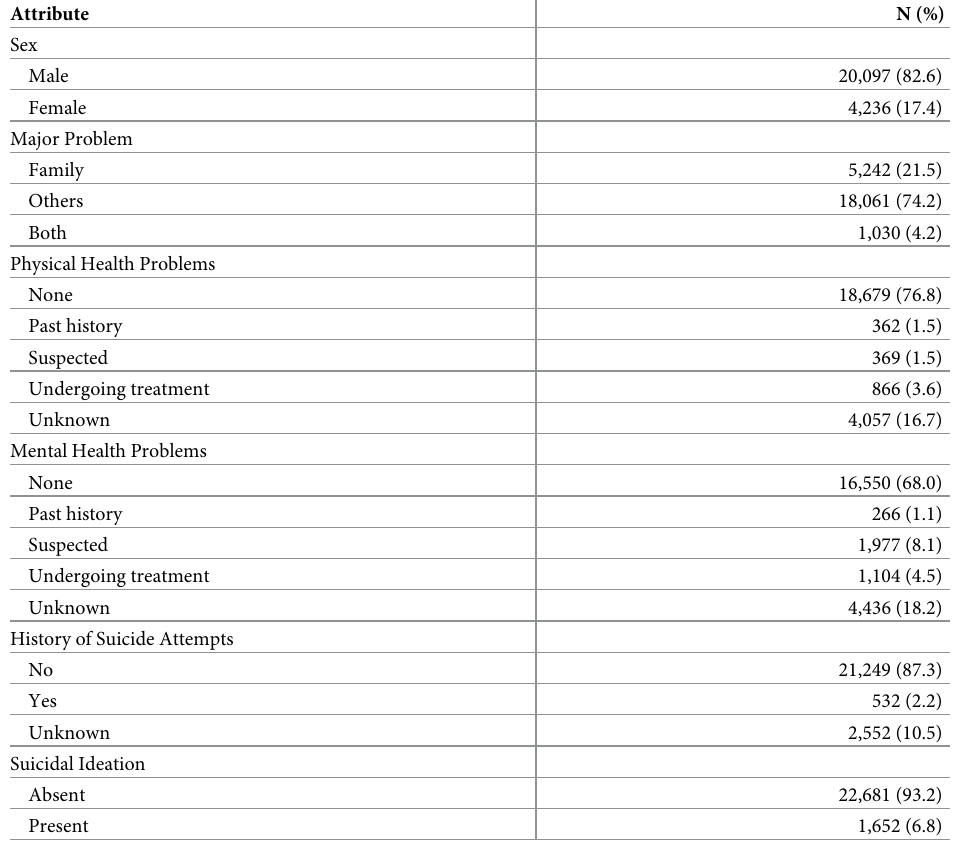
Table 1. Demographic characteristics of callers under 20 years of age (N =